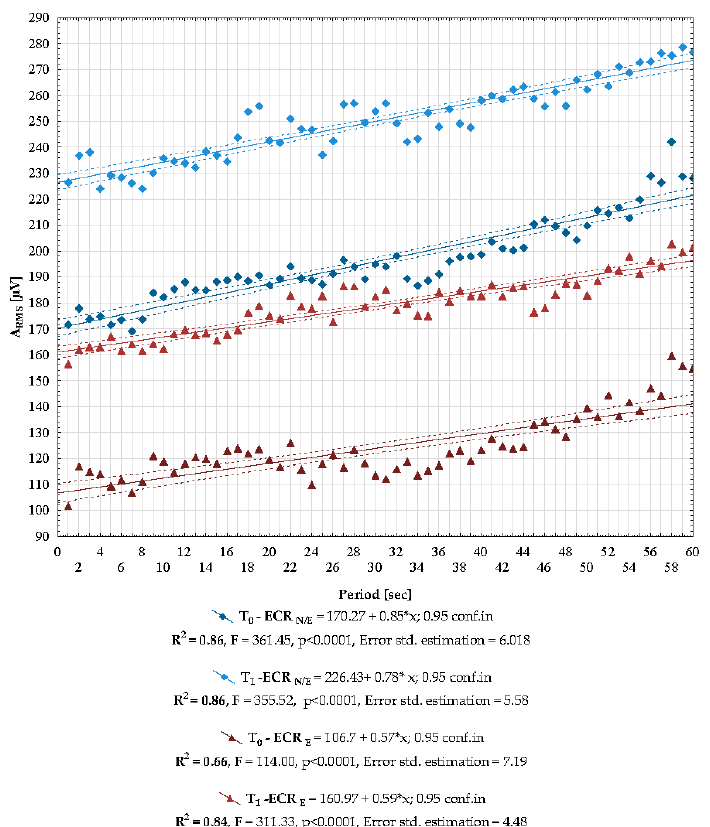
Figure 3. Change in the A RMS value recording during a 60 s fatigue isometric contraction. Legend: A RMS —root-mean-square amplitude, ECR—extensor carpi radialis longus and brevis muscles, E — enthesopathy, N/E —healthy side. Table 1. Analysis of the effect of local cryotherapy on the A RMS value recording during a 60 s con- traction.